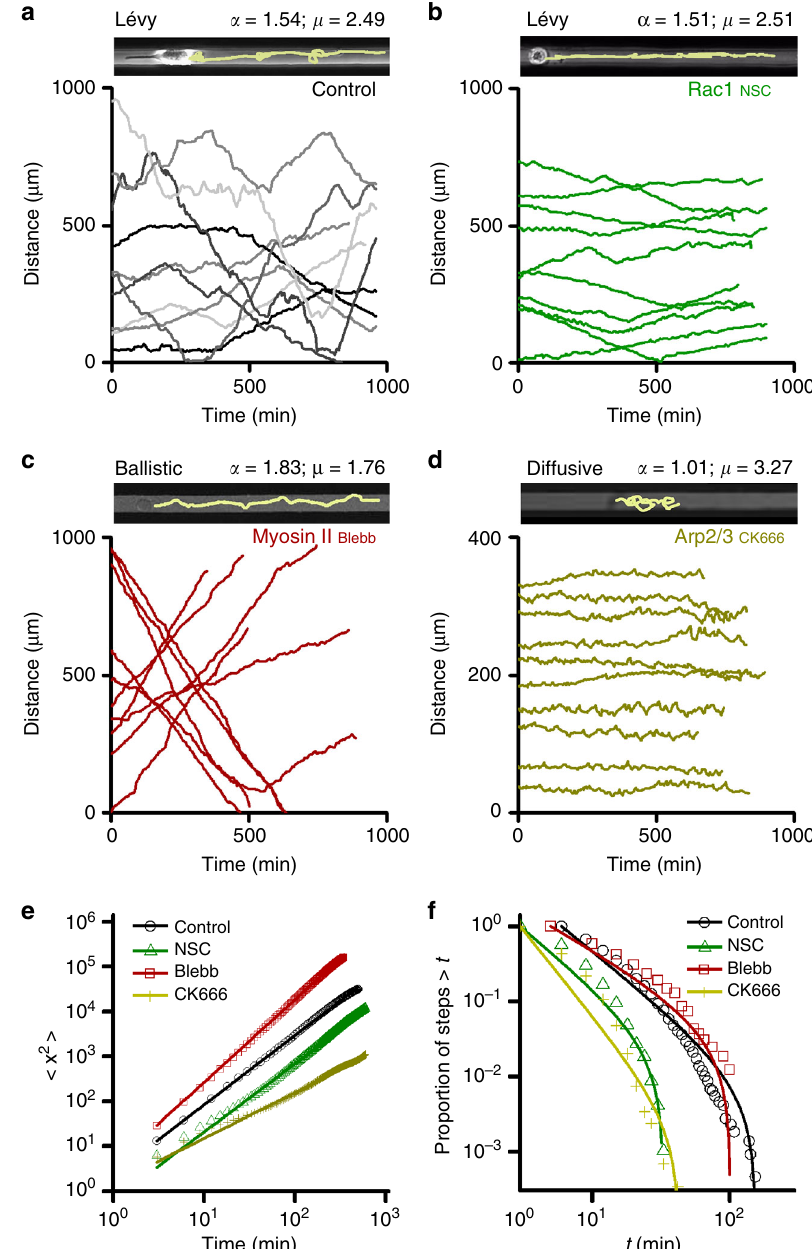
Fig. 5 Altering the motility strategy of metastatic cancer cells. Examples of typical cell trajectories: Lévy walking (control MDA-MB-231 cells, a or with Rac1 inhibited, b ), ballistic (Myosin II inhibited, c ) diffusive (Arp2/3 inhibited, d ). Line width = 20 μ m, same for all three images. In displacement plots, ten representative trajectories for each treatment are shown. Quanti fi cation of motility characteristics (exponents μ , α along with the ± 95% con fi dence intervals) for MDA-MD-231 cells moving on microtracks and having individual actin-binding proteins inhibited is summarized in Table 3. e Log – log plots of (cid:1) (cid:3) ¼ t α . The slopes correspond to exponents α ; note that inhibition of Arp2/3 with CK666 results in the cells ’ mean square displacement versus time, x 2 diffusive motion, α ~ 1, while inhibition of Myosin II results in ballistic motion, α ~ 2. f The corresponding cumulative frequency distributions, CFDs, of persistence times. Markers are experimental statistics for persistence times. Solid lines are truncated power law fi ts with respective μ values shown in Table 3. For the chemical inhibitors data shown corresponds to: 40 μ M CK666 (for Arp2/3, yellow crosses), 100 μ M NSC23755 (Rac1, green triangles), 10 μ M Blebbistatin (Myosin II, red rectangles), and control (black circles). The additional results for all drug and siRNA concentrations tested are shown